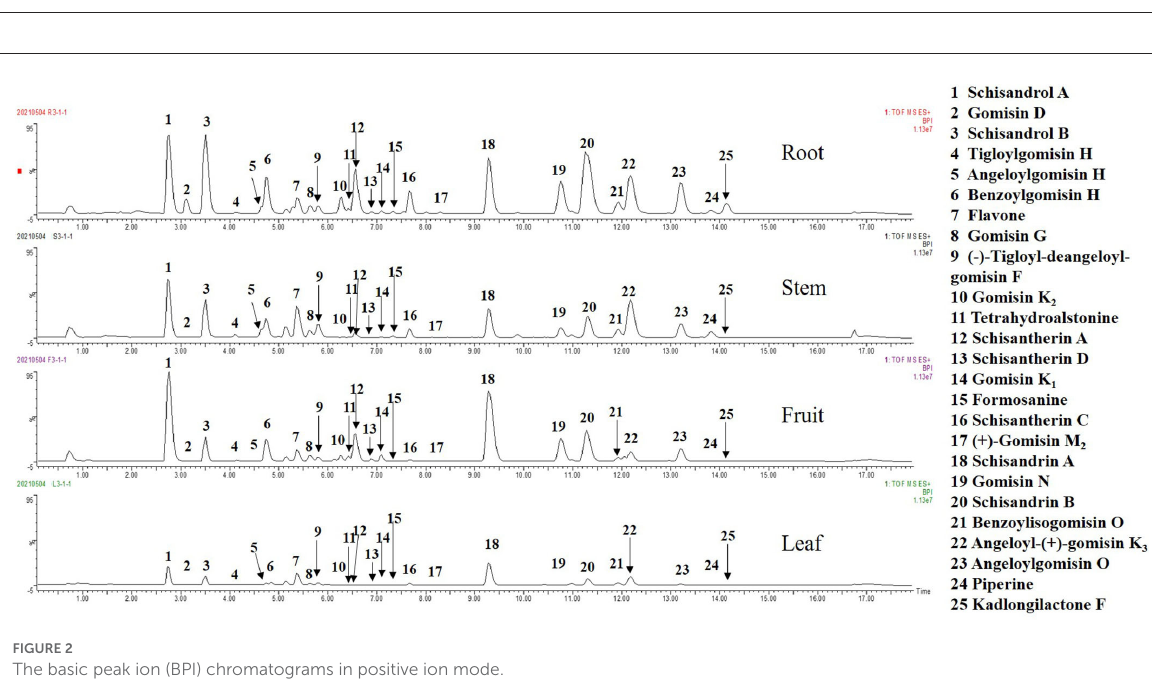
were higher in roots, while the contents were lower in leaves and stems. The difference in the metabolite spectrum may also help to explain the different efficacies of different parts of S. chinensis